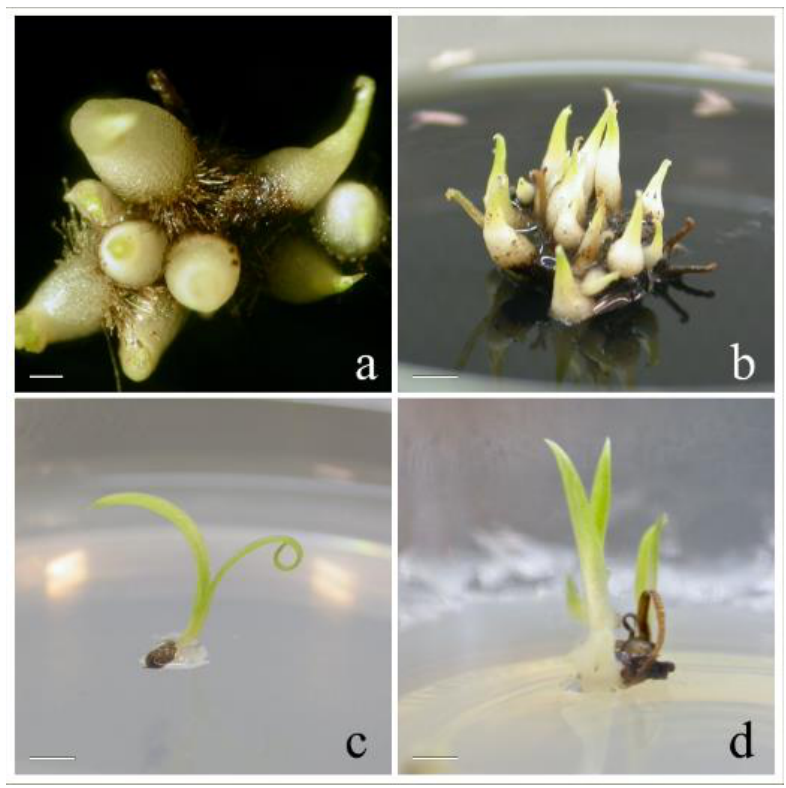
Figure 6. Different growth patterns of Anacamptis longicornu seedlings in the two culture media: ( a , b ) seedlings on OM medium; ( c , d ) seedlings on MS medium.